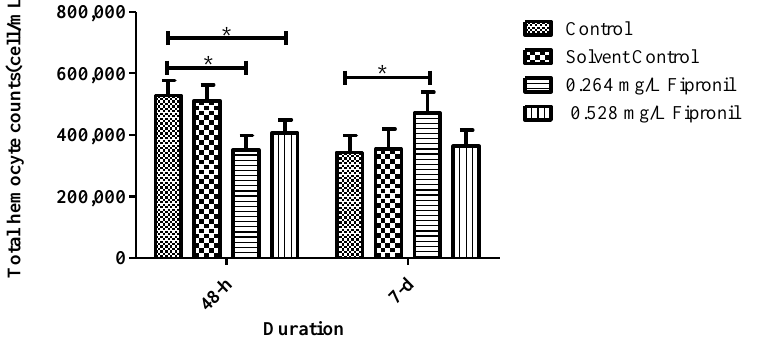
Figure 1. The Total Haemocyte Counts (THCs) (mean ± SEM) of freshwater mussels (* indicates p <